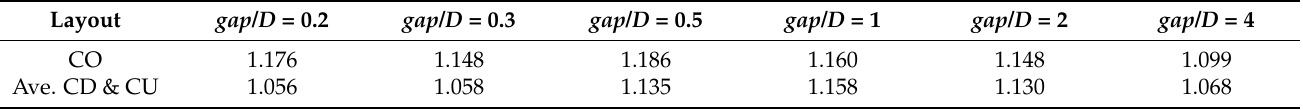
Table 1. Averaged values of normalized powers under assumption of isotropic bidirectional wind speed. Layout gap / D =